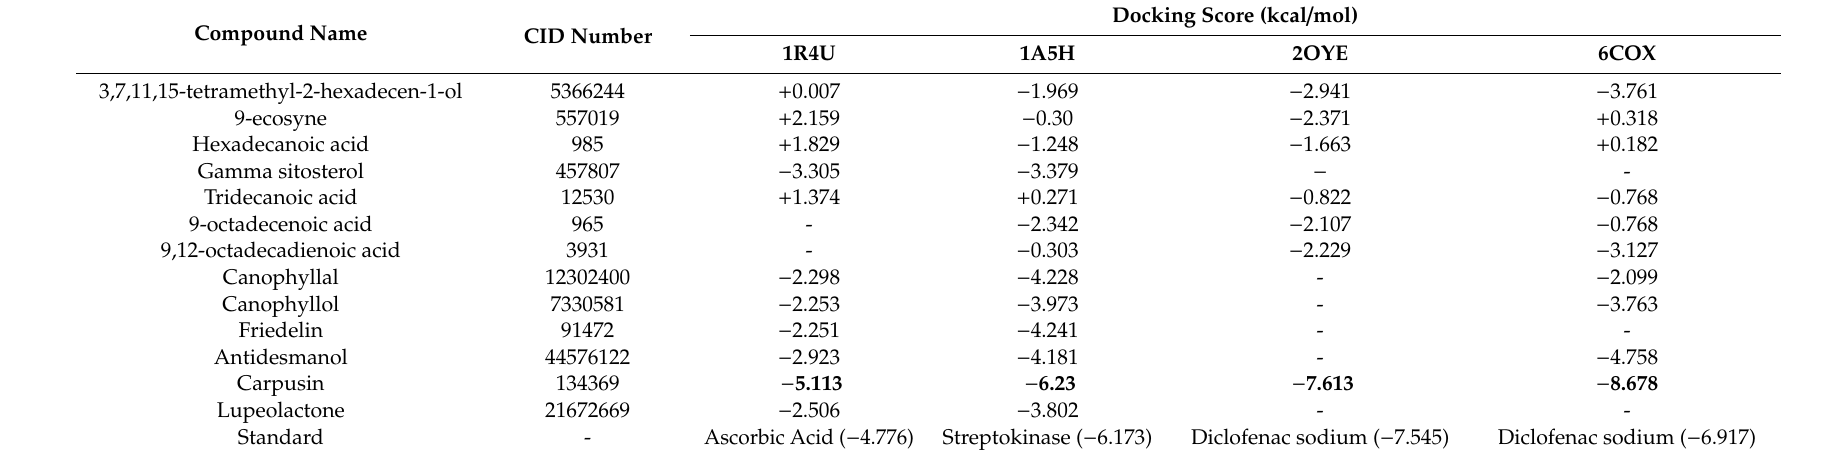
Table 6. Molecular docking analysis of major bioactive